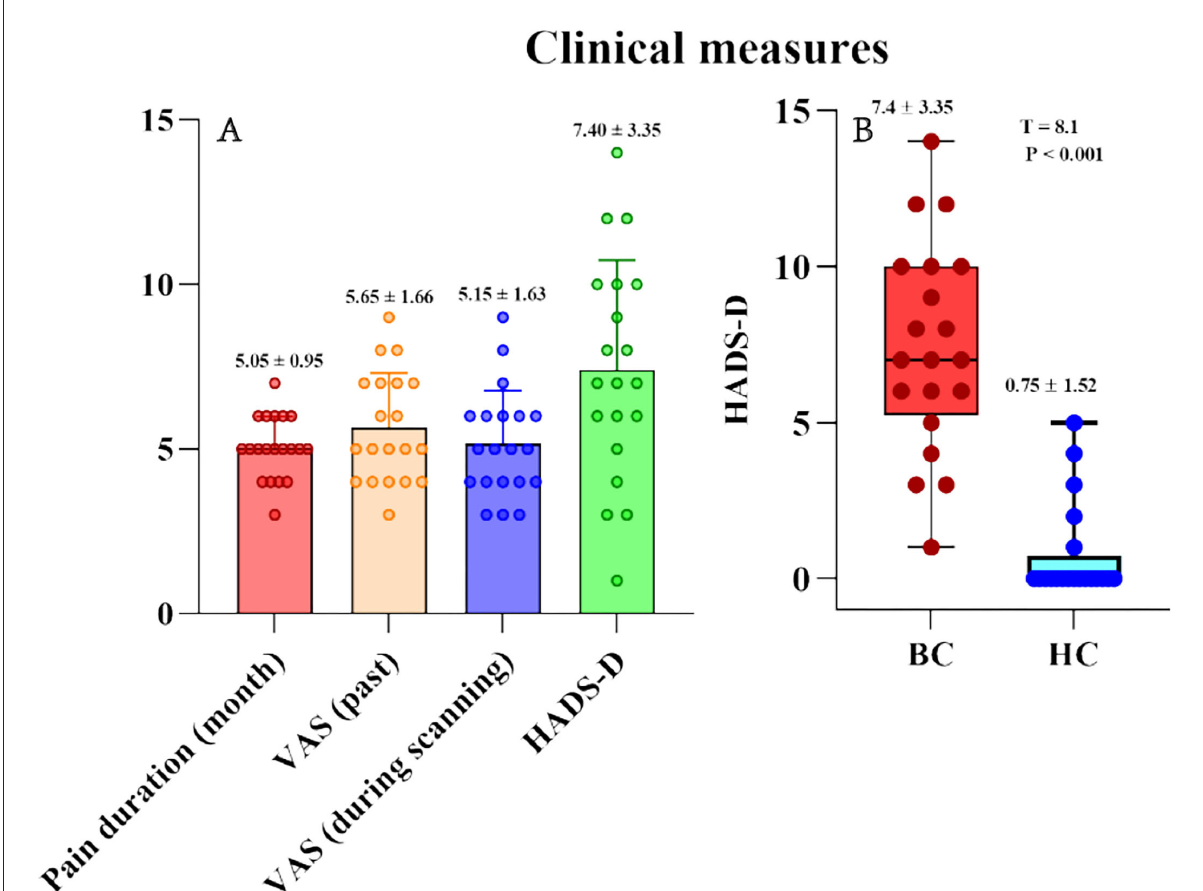
FIGURE1 Pain characteristics (VAS and pain duration) and psychological variables (HADS-D) of BC patients and healthy controls. (A) Pain characteristics (VAS and pain duration) and HADS-D in BC patients. (B) HADS-D were significantly larger in BC patients than that in healthy controls. HADS-D, Hospital Anxiety and Depression